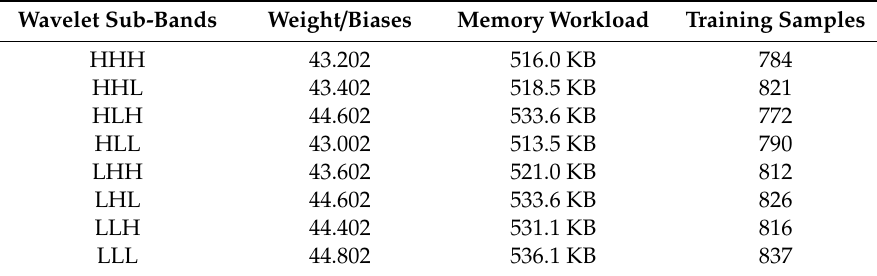
Table 2. Computational Complexity of Classification